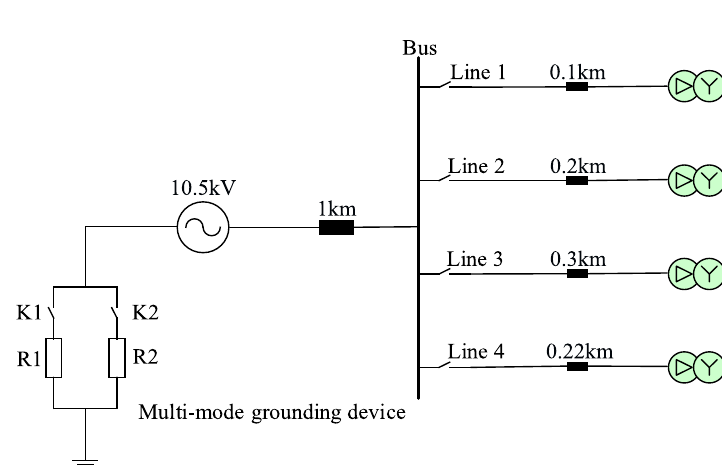
Fig. 1 Floating nuclear power plant MV